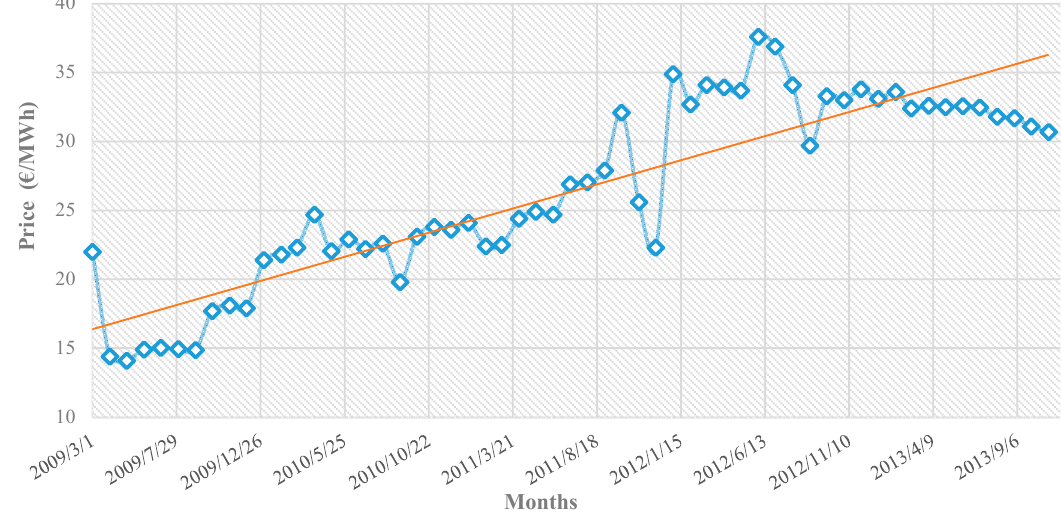
Figure 11. Evolution of the monthly weighted average import price of natural gas in Greece during the period 2009 to 2013.